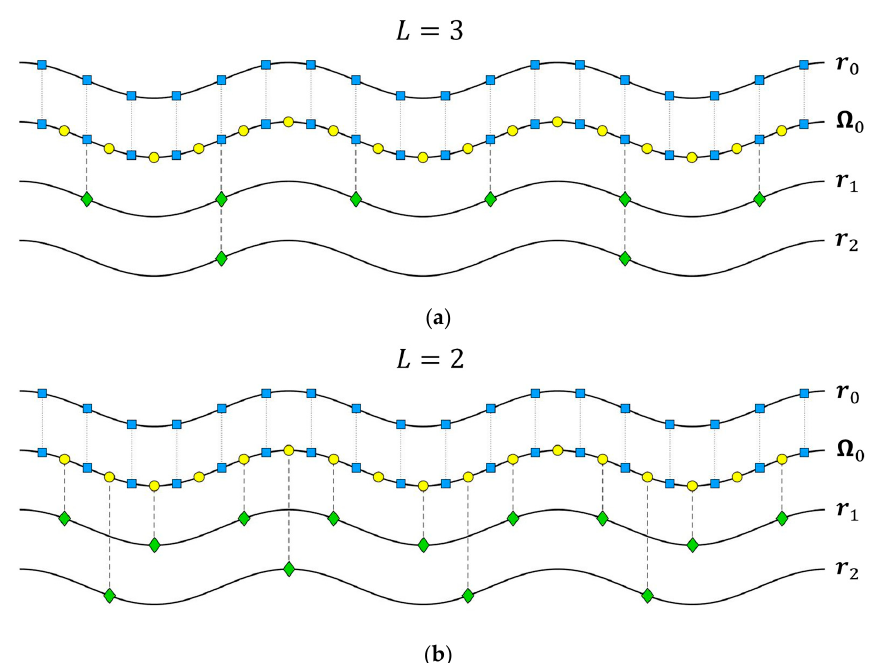
Figure 2. Definition of child subapertures for ( a ) 𝐿 = 3 and ( b ) 𝐿 = 2 . The blue squares, yellow circles, and green diamonds represent the radar root positions, the midpoints between them, and the child subapertures phase centers, respectively. Reprinted with permission from ref. [20]. Copyright